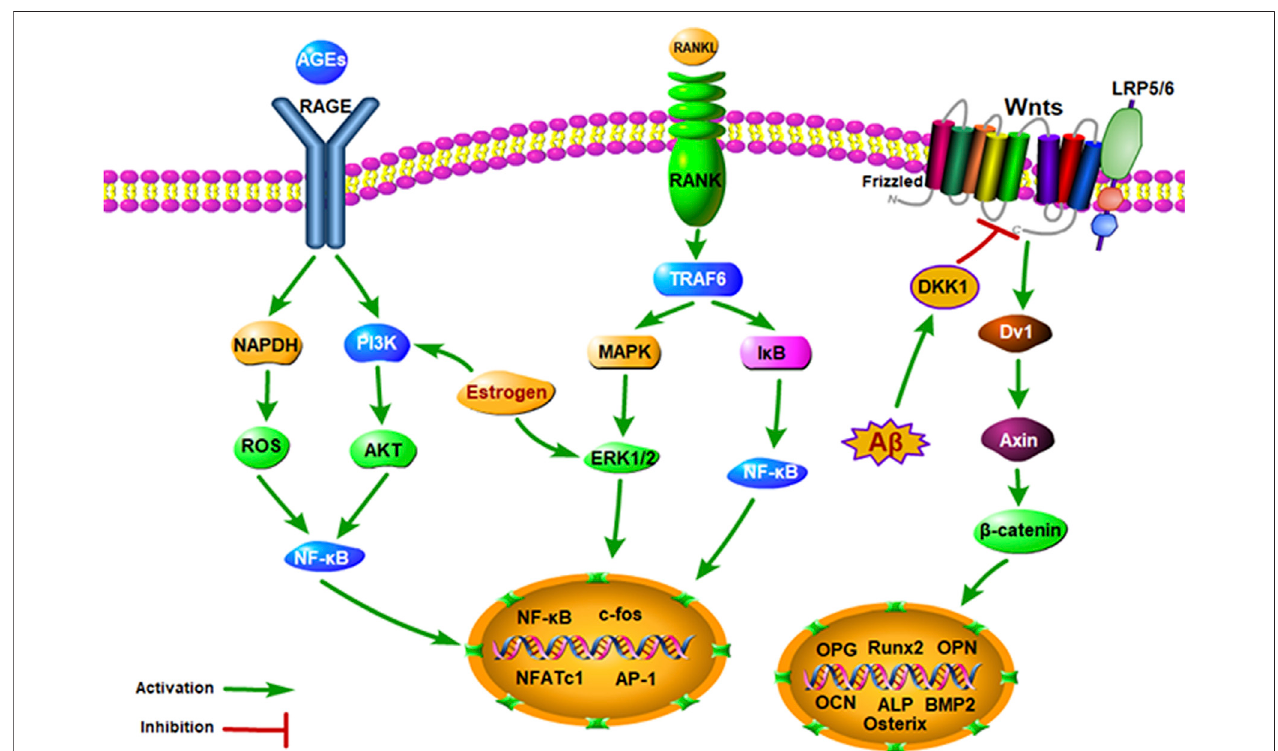
FIGURE 2 | Signaling pathways involved in the common pathogenesis of AD and